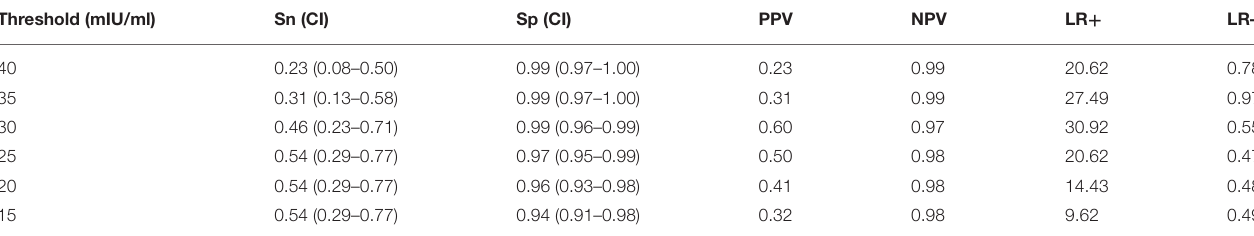
TABLE 3 | The sensitivity (Se), specificity (Sp), positive predictive value (PPV), confidence intervals (CI), negative predictive value (NPV), likehood ratios + ’ve (LR+) and likehood ratios − ’ve (LR − ) for predicting ovulation within 24 h at 15, 20, 25, 30, 35, and 40 mIU/ml thresholds on the 11th day of the cycle. Threshold